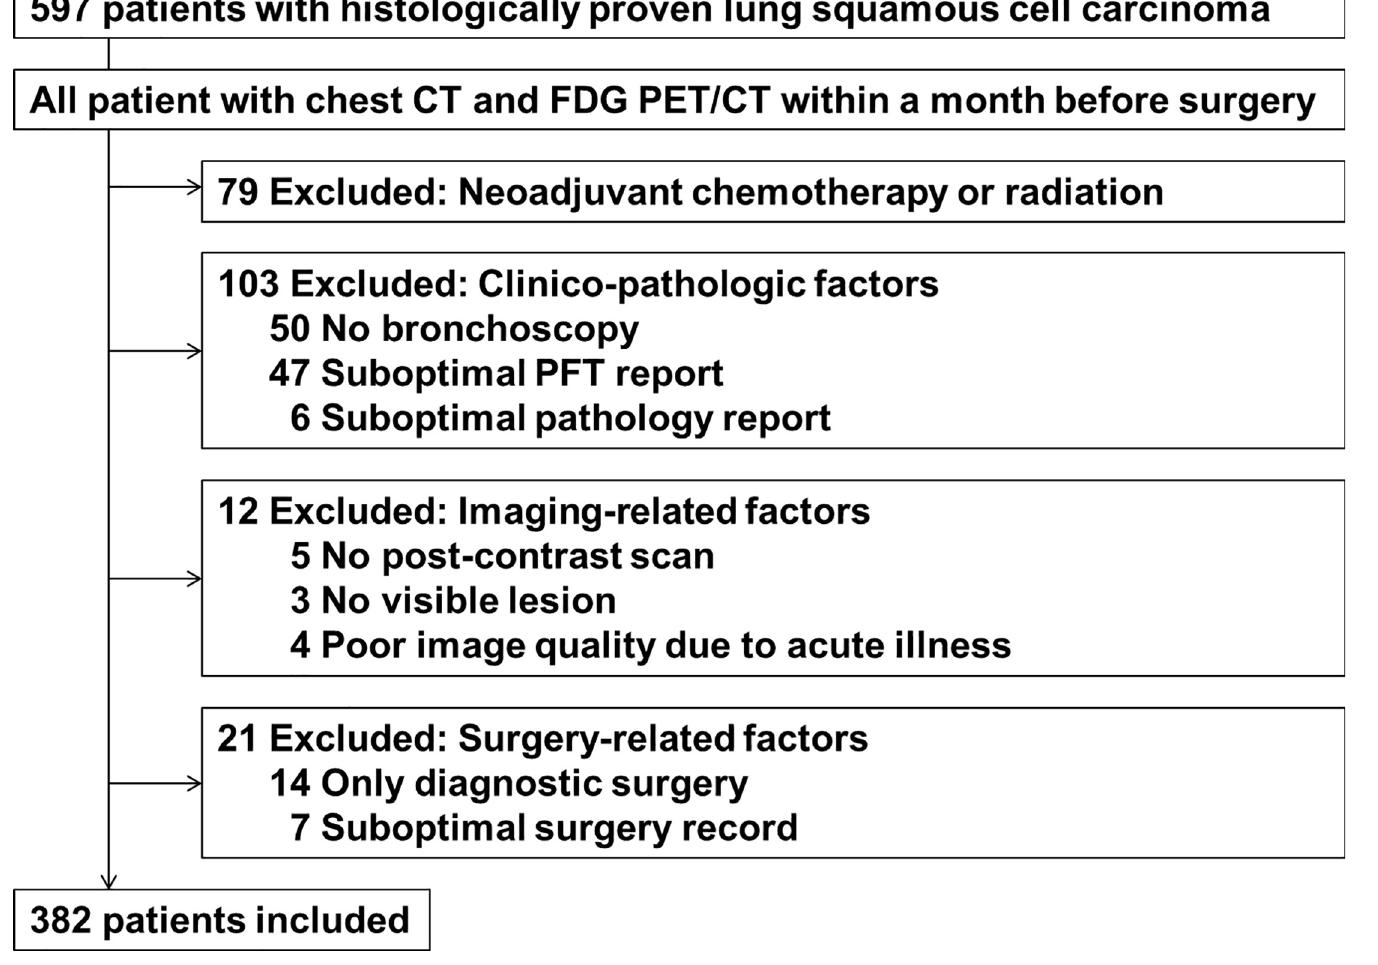
Fig 1. Flowchart of the enrollment process.